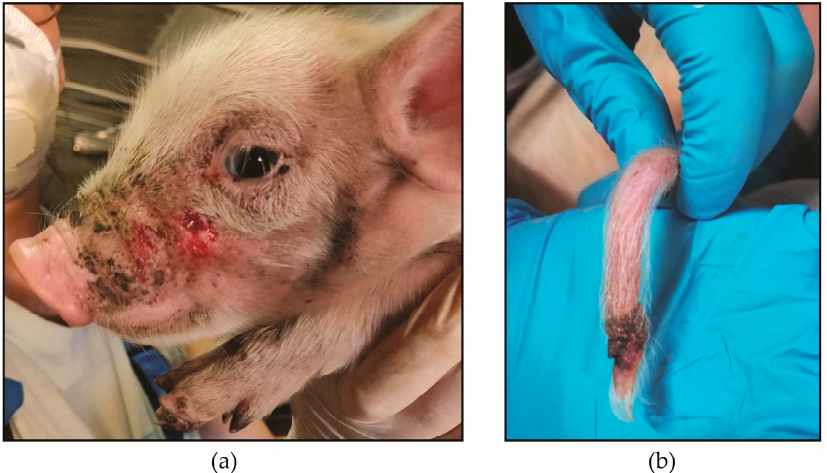
Figure 3. Example of severe lesions (score 2) observed in the study. ( a ) = front lesions; ( b ) = tail lesion.